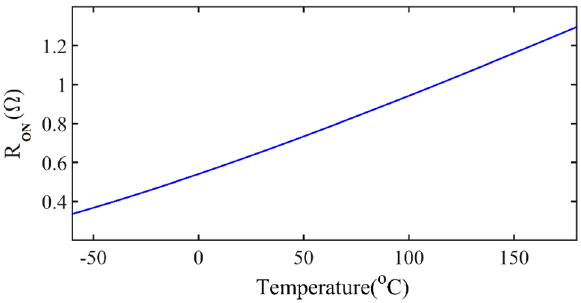
Figure 5. The dependence of R ON as a function of temperature for the IRF510 transistor when VGS = 5.2